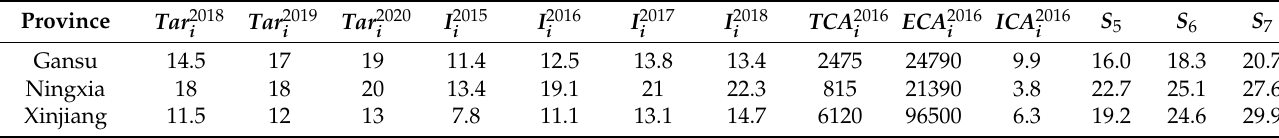
Table 4. Generation rights trading scenarios of Northwest China 1